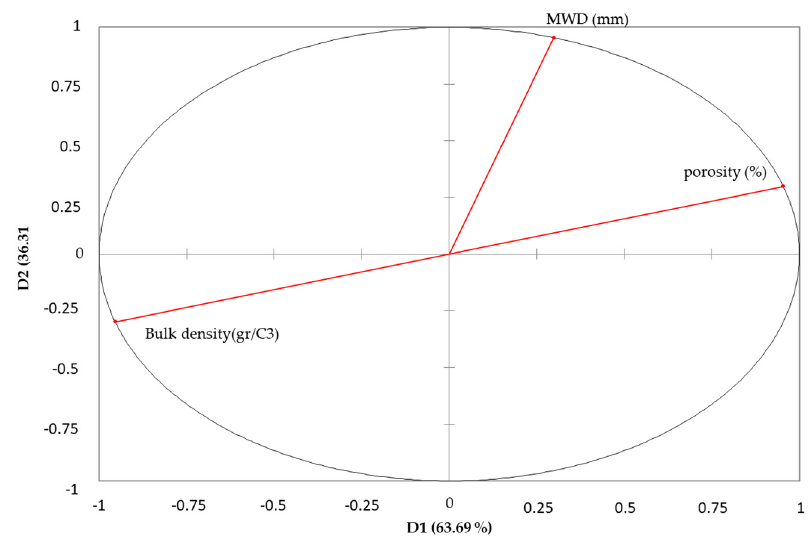
Figure 6. Varimax rotation biplot for soil physical characteristics.